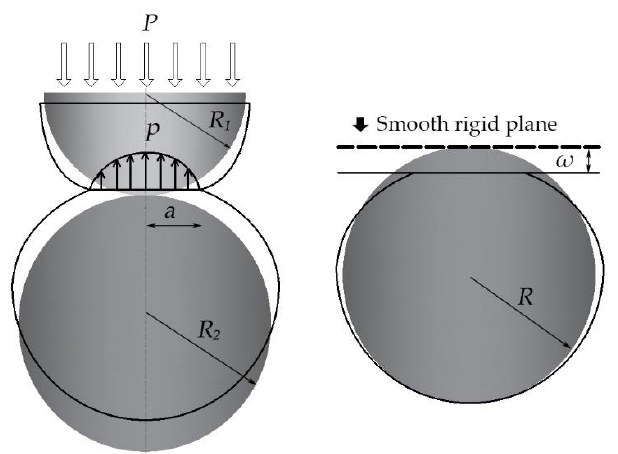
Figure 8. Schematic diagram of the Hertz contact of filling particles.